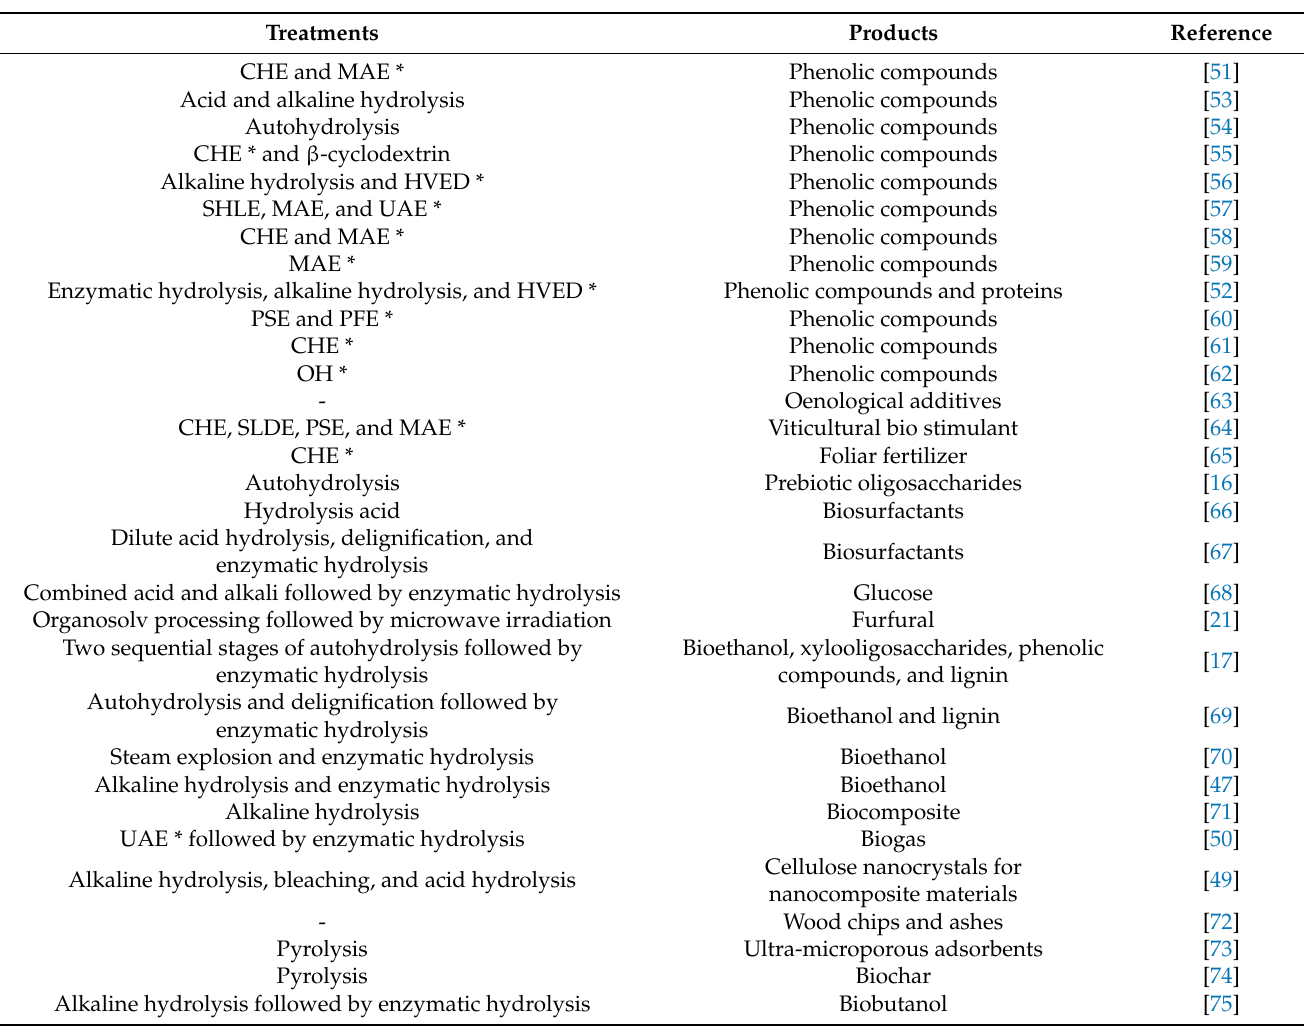
Table 2. Treatments of VPR that lead to valorisation into different products following the concept of